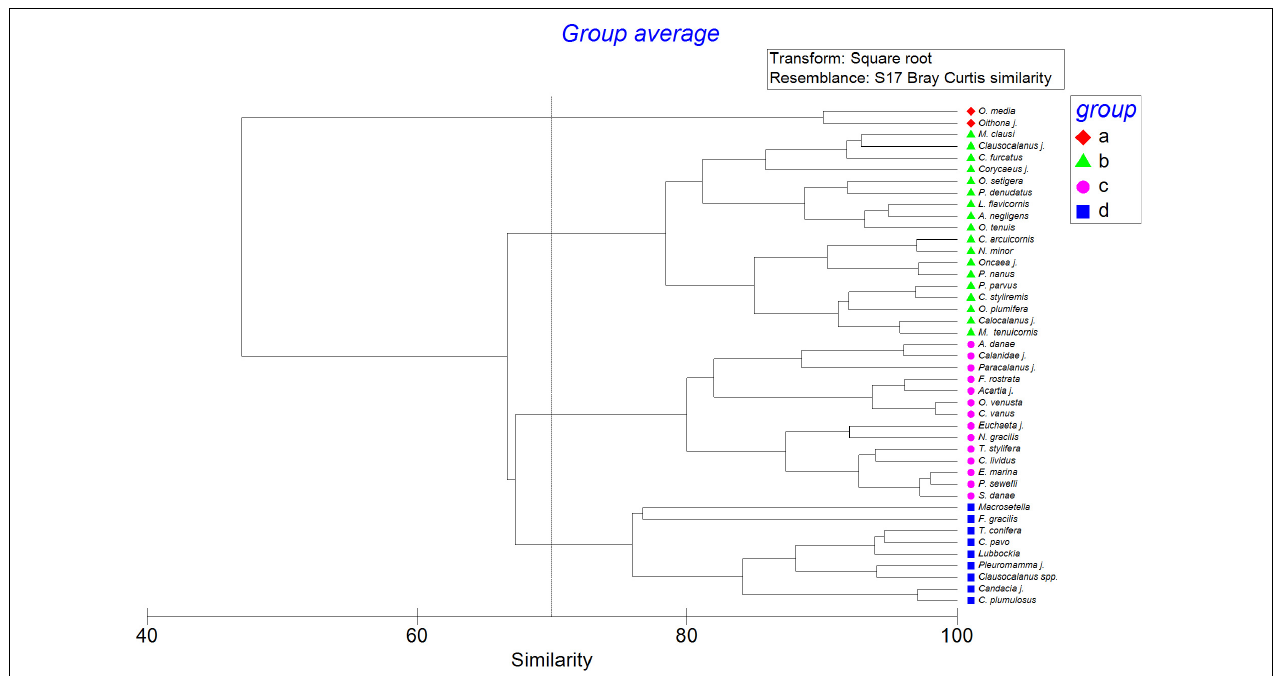
FIGURE 7 | Cluster dendrogram of the dominant copepod taxa ( > 1%) over the 6 year study taken in the study area of El Hierro considering their abundance as ind m − 3 after square root transformation and resemblance based on Bray Curtis